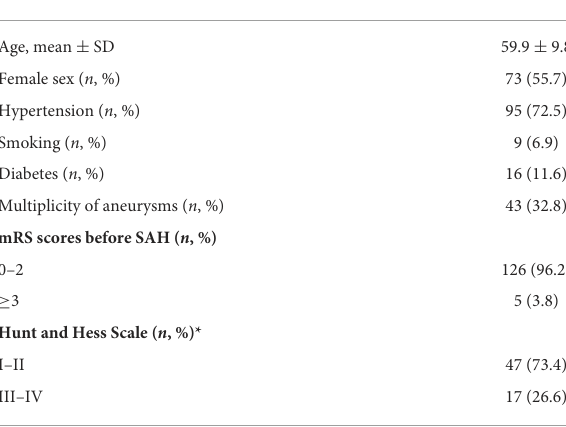
TABLE 1 Characteristics of 131 patients. TABLE 2 Characteristics of 135